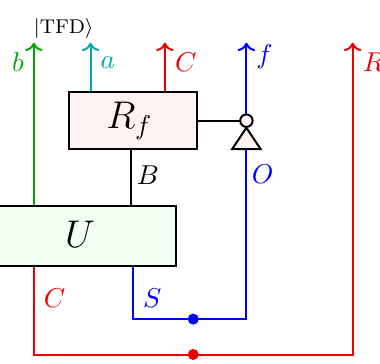
Figure 10. The recovery operator R acts on the tensor product of the black hole Hilbert space B and the observer Hilbert space O . The final state after the recovery operation consists of the tensor product of the initial state | Ψ i and the thermofield double state of the late radiation b and C ancilla a